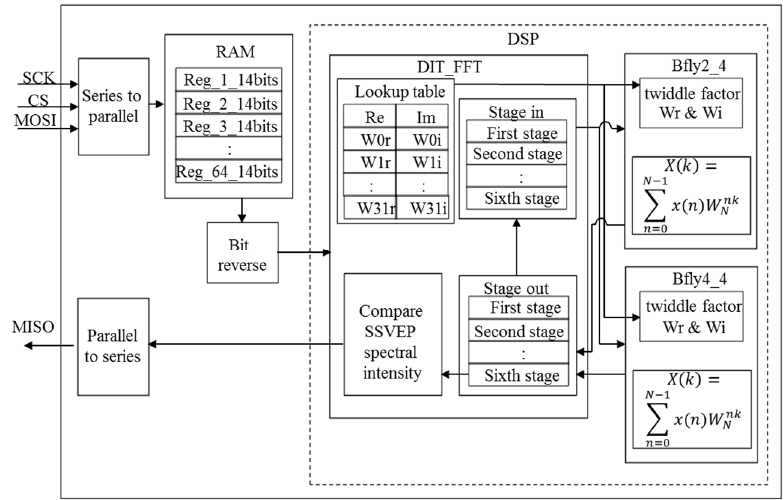
Figure 6. Hardware architecture of SSVEP BCI algorithm in FPGA.